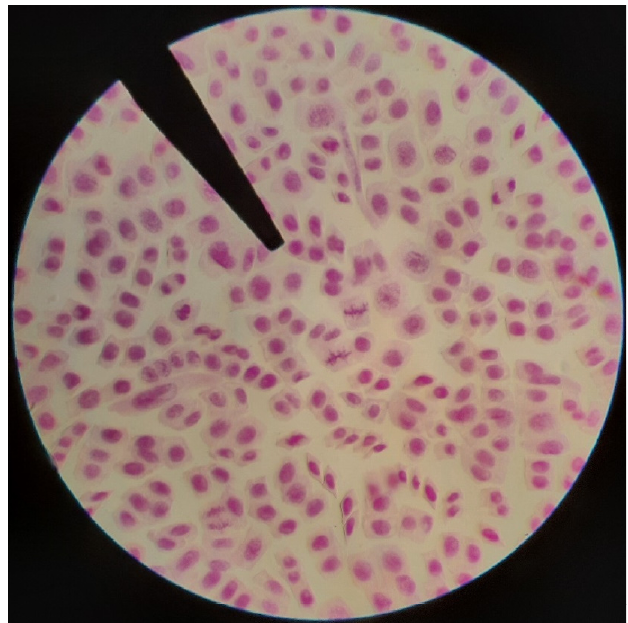
Figure 7. Mitotic slide from Zantedeschia root tips illustrating the dividing cells (BAUSCH&LOMB, 150X power). 150X power).